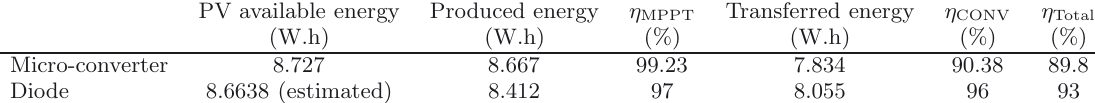
Table 2. Results of the two conversion stages performance on one operating day.